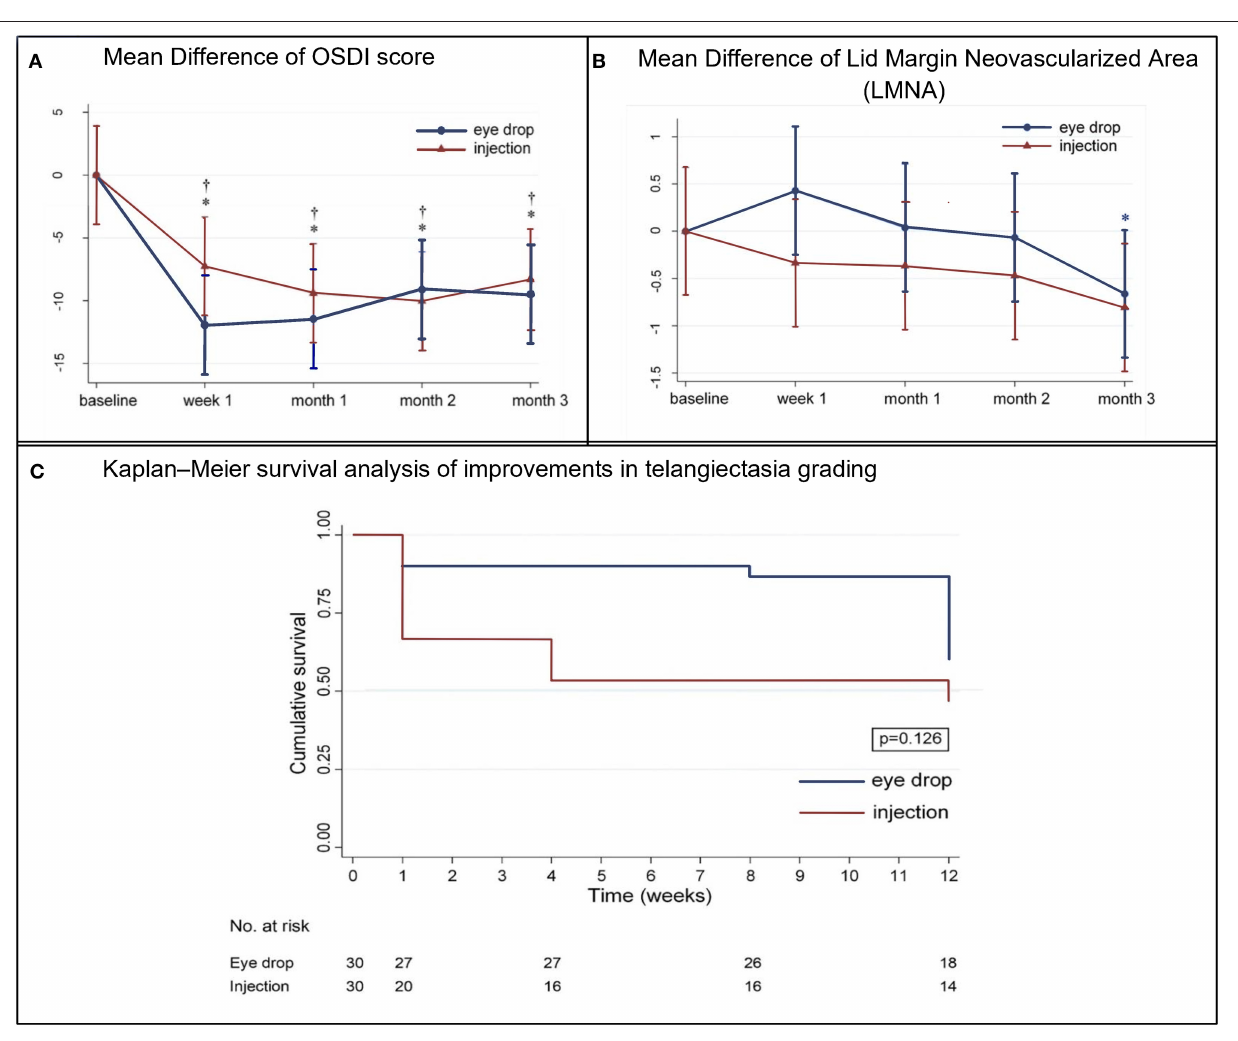
FIGURE 4 | (A) Mean ( ± standard deviation) difference in the Ocular Surface Disease Index (OSDI) scores from baseline at each visit. † p < 0.05, within-eye drop group differences. * p < 0.05, within-injection group differences. (B) Mean ( ± standard deviation) difference in lid margin neovascularized area from baseline at each visit. * p < 0.05, within-injection group differences. (C) Kaplan–Meier survival analysis of improvements in telangiectasia